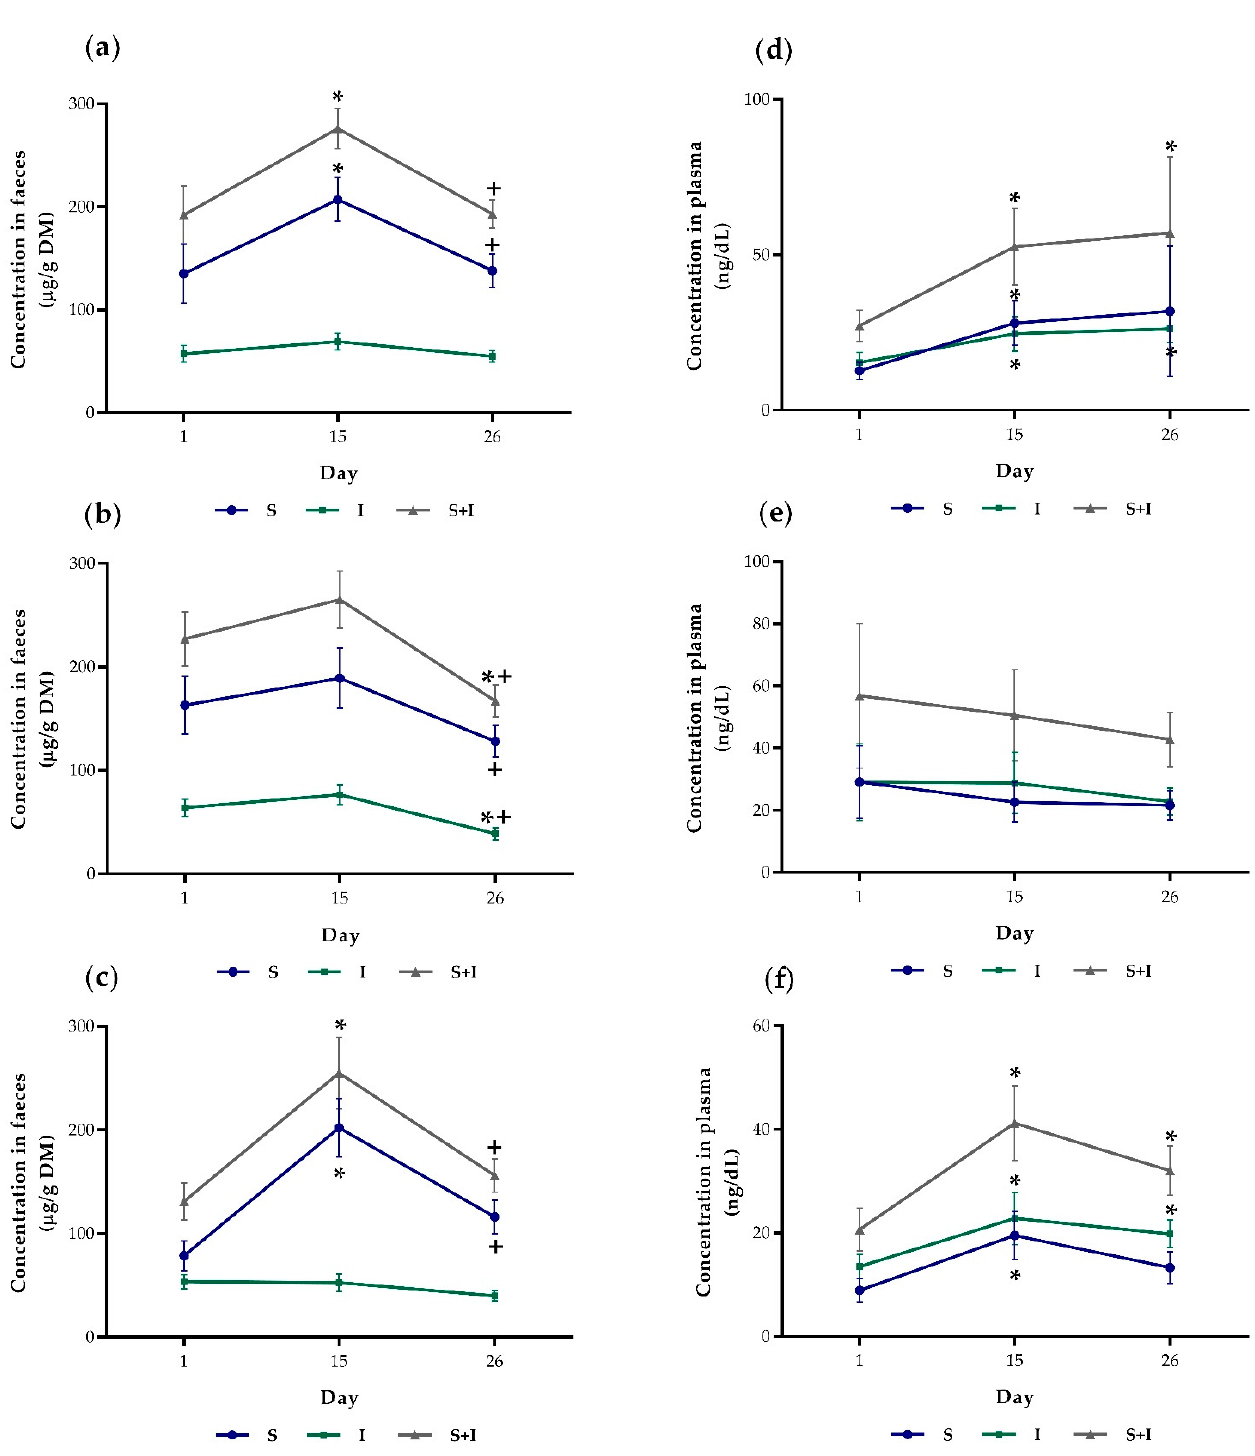
Figure 2. Skatole (S), indole (I) and sum of skatole and indole (S + I), concentrations (mean ± S.E.M.) in faeces of BC0 ( a ), BC2 ( b ) and BC4 ( c ) as well as plasma of BC0 ( d ), BC2 ( e ) and BC4 ( f ), respectively. * Indicates values are significantly different from values at day 1. + Indicates values are significantly different from values at day 15. DM, dry matter. SEM, standard error of the